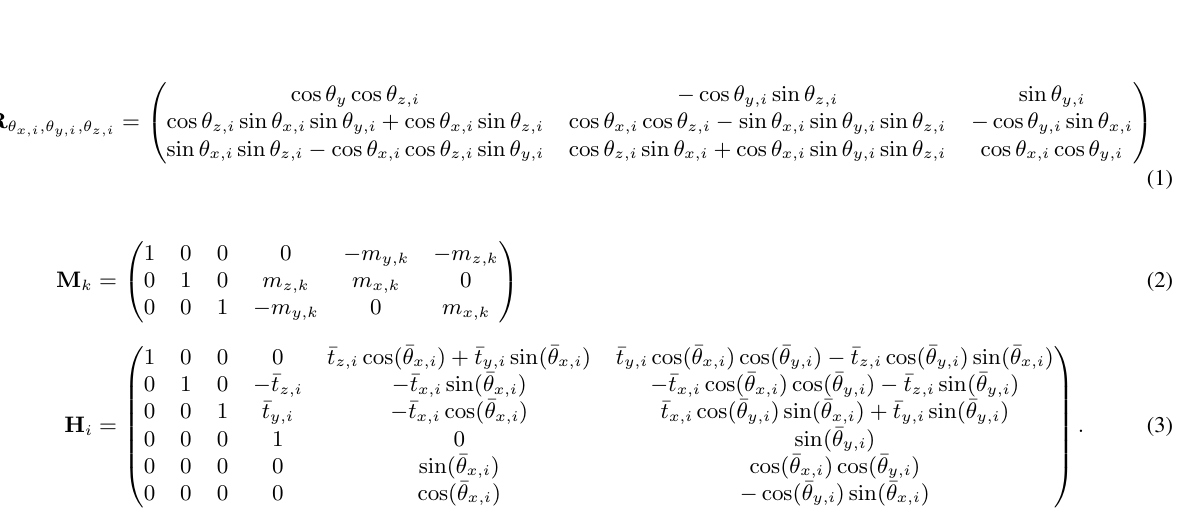
Figure 3: Definition of the rotation matrix and the matrix decompositions.